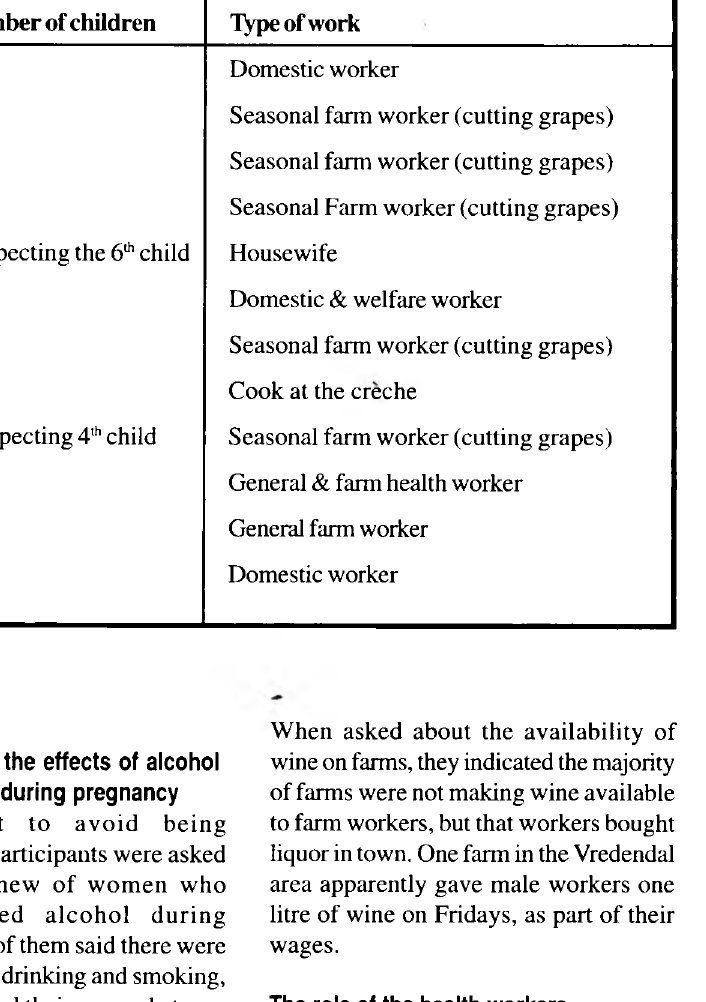
Table 1B: Description of Women participating in Semi-structured Interviews